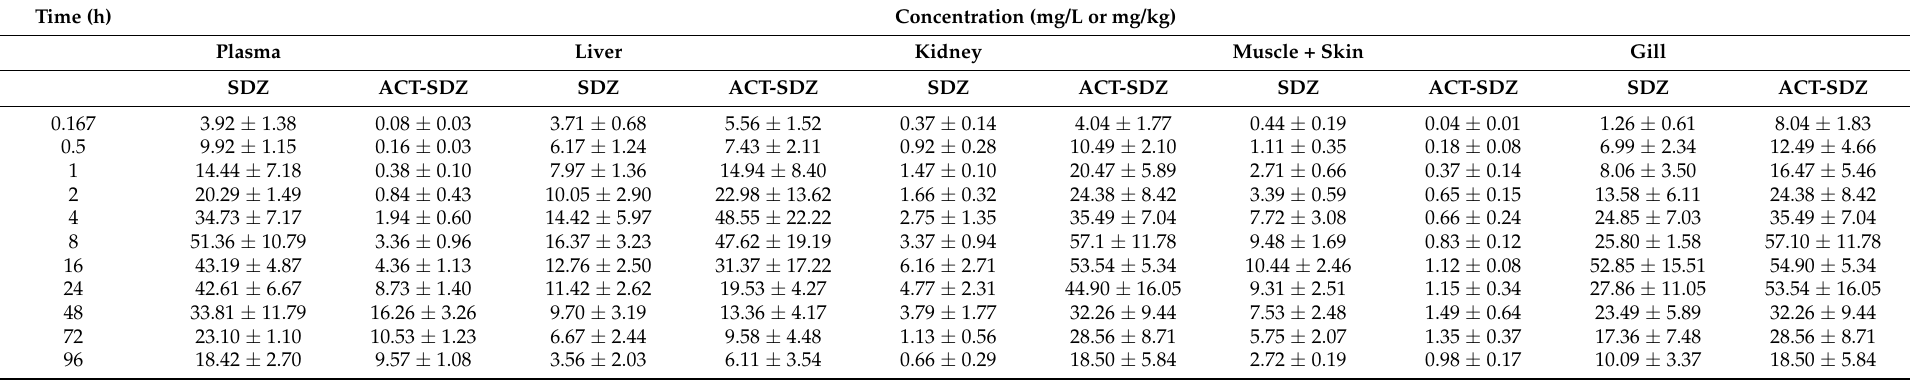
Table 1. Sulfadiazine and N-acetyl sulfadiazine concentrations in plasma and tissues of grass carp ( Ctenopharyngodon idella ) after oral administration of a single dose of sulfadiazine at 50 mg/kg at 18 ◦ C.